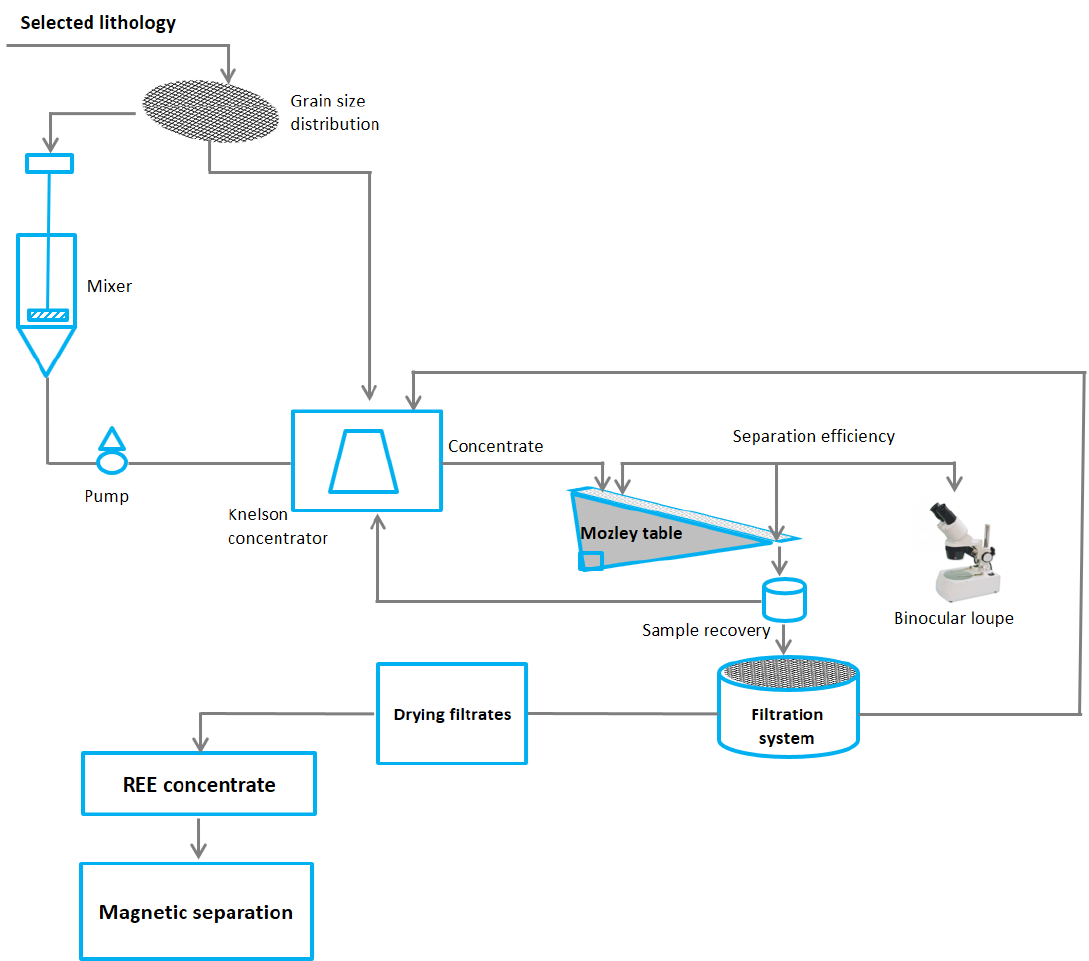
Figure 2. Experimental set-up for the Mozley table and Knelson concentrator tests.